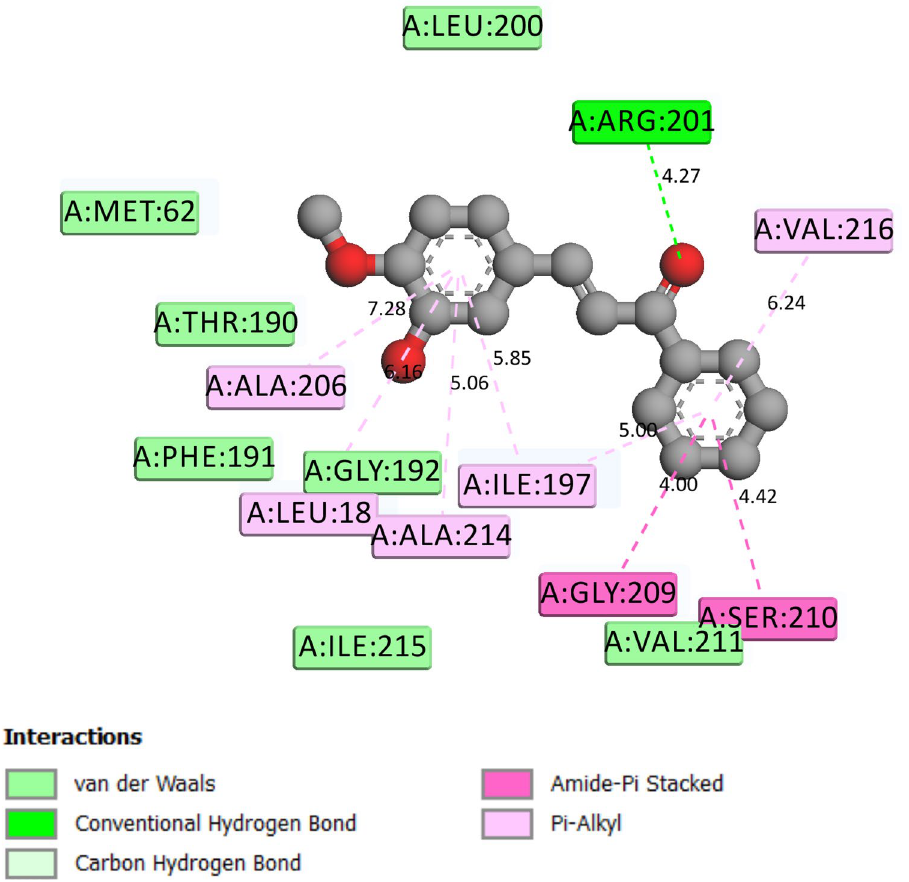
Figure 2. Rrepresentation of the binding interactions between compound 6e and the amino residues of